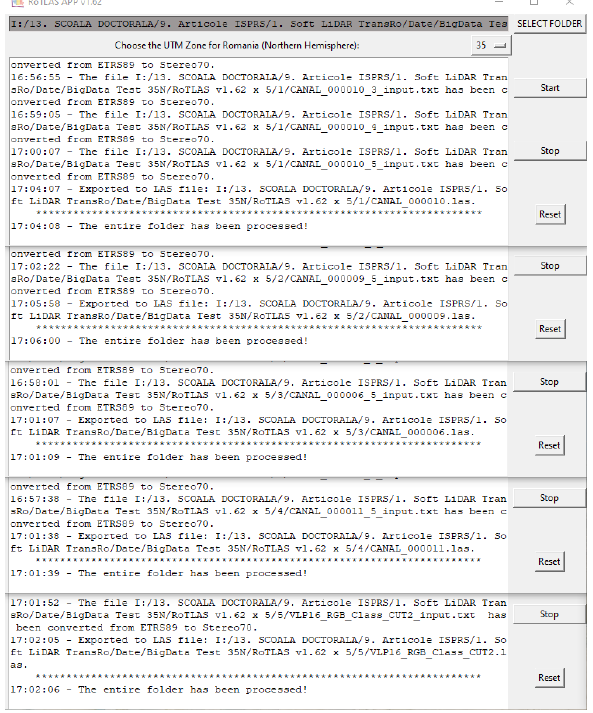
Figure 10 . Running multiple sessions of RoTLAS APP v1.62